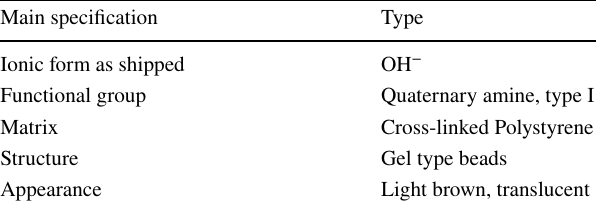
Table 1 Main specifications of anionic resin (M-500)